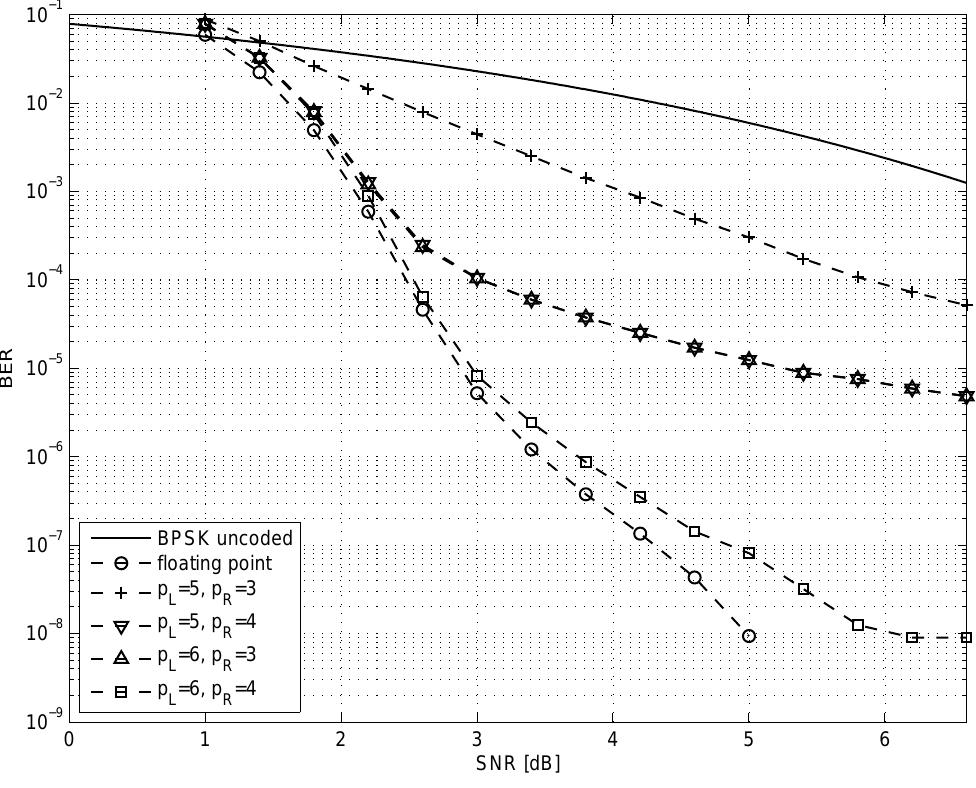
Figure 3. BER performance of the N = 576 LDPC